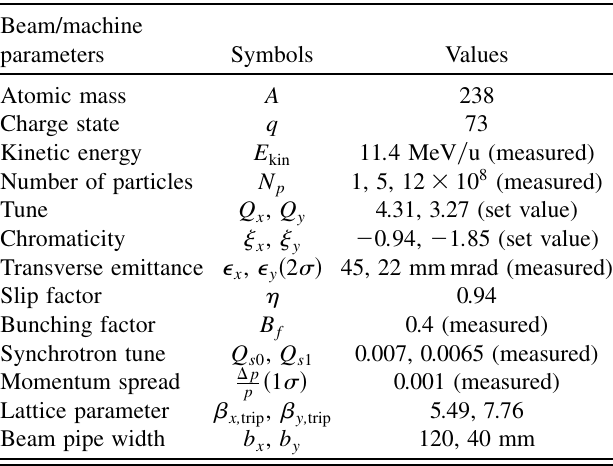
TABLE I. Beam parameters during the U 73 þ